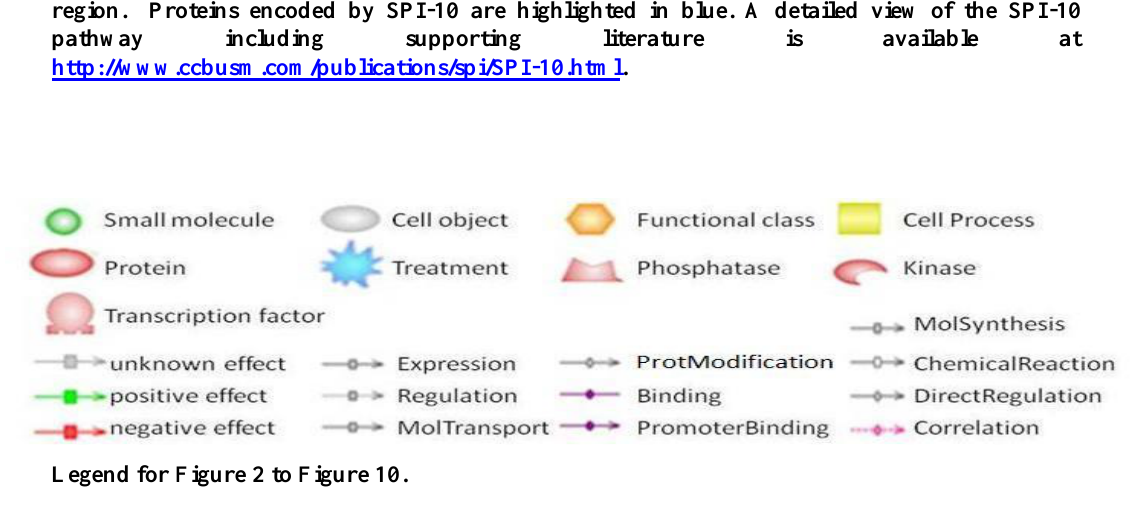
pathway including supporting literature is available at